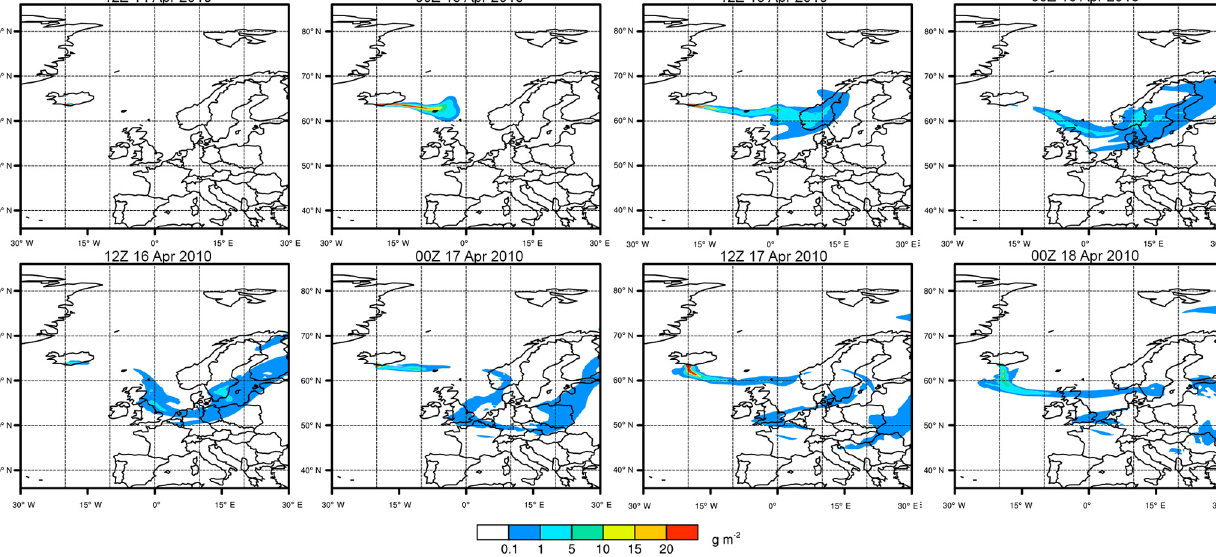
cast indicate mostly hits ( H ), Fig. 8 clearly suggests that the number of missed ( M ) and false alarm (FA) points increases with longer coupling intervals and the length of the